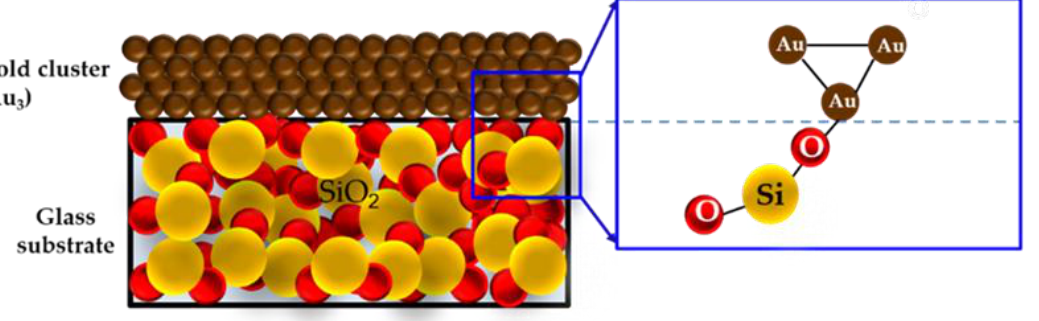
Figure 9. Schematic diagram of the bonding of the gold cluster atoms (Au 3 ) on a glass substrate (SiO 2 ).